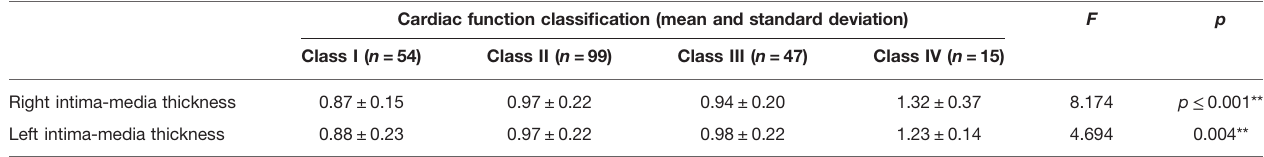
TABLE 4 | Variance analysis between the cardiac functional grade and the right intima-media thickness and the left intima-media thickness. Cardiac function classi fi cation (mean and standard deviation)